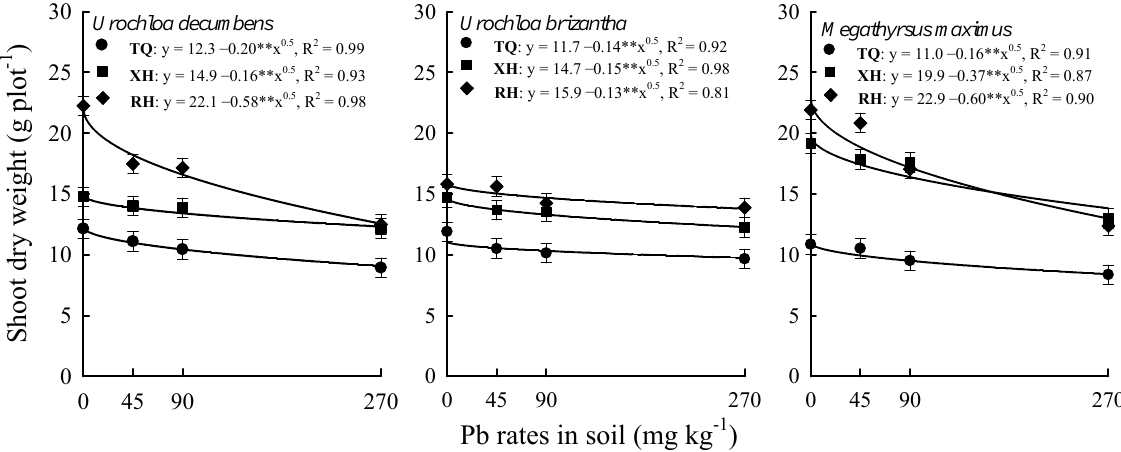
Figure 1. Shoot dry weights of forage grasses with increases in Pb rates within 120 days of thinning in three soils (TQ: Typic Quartzipsamment. XH: Xantic Hapludox. RH: Rhodic Hapludox) (significant at ** p = 0.01).